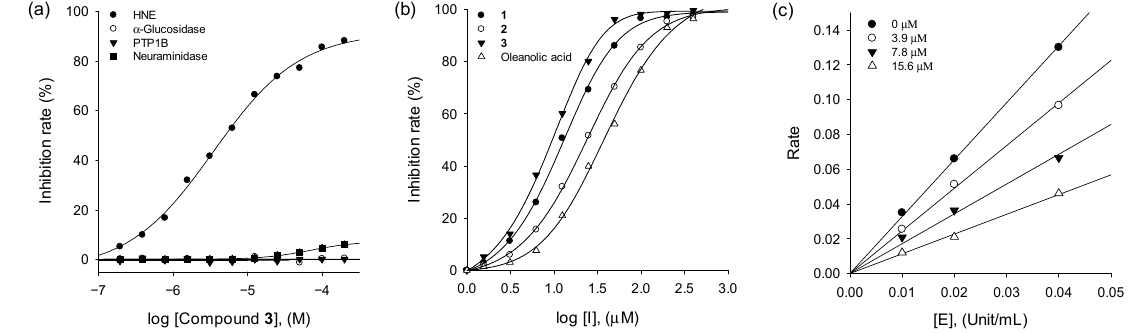
Figure 2. ( a ) Selectivity of compound 3 on HNE in different hydrolase enzymes. ( b ) Dose-dependent HNE inhibition by iridal-type triterpenoids ( 1 – 3 ). ( c ) Determination of the reversible inhibitory mechanism of 3 . Table 1. Inhibitory effects of iridal-type triterpenoids ( 1 – 3 ) on HNE activity. Compounds IC 50 a (µM) Type of Inhibition ( K i b , µM)